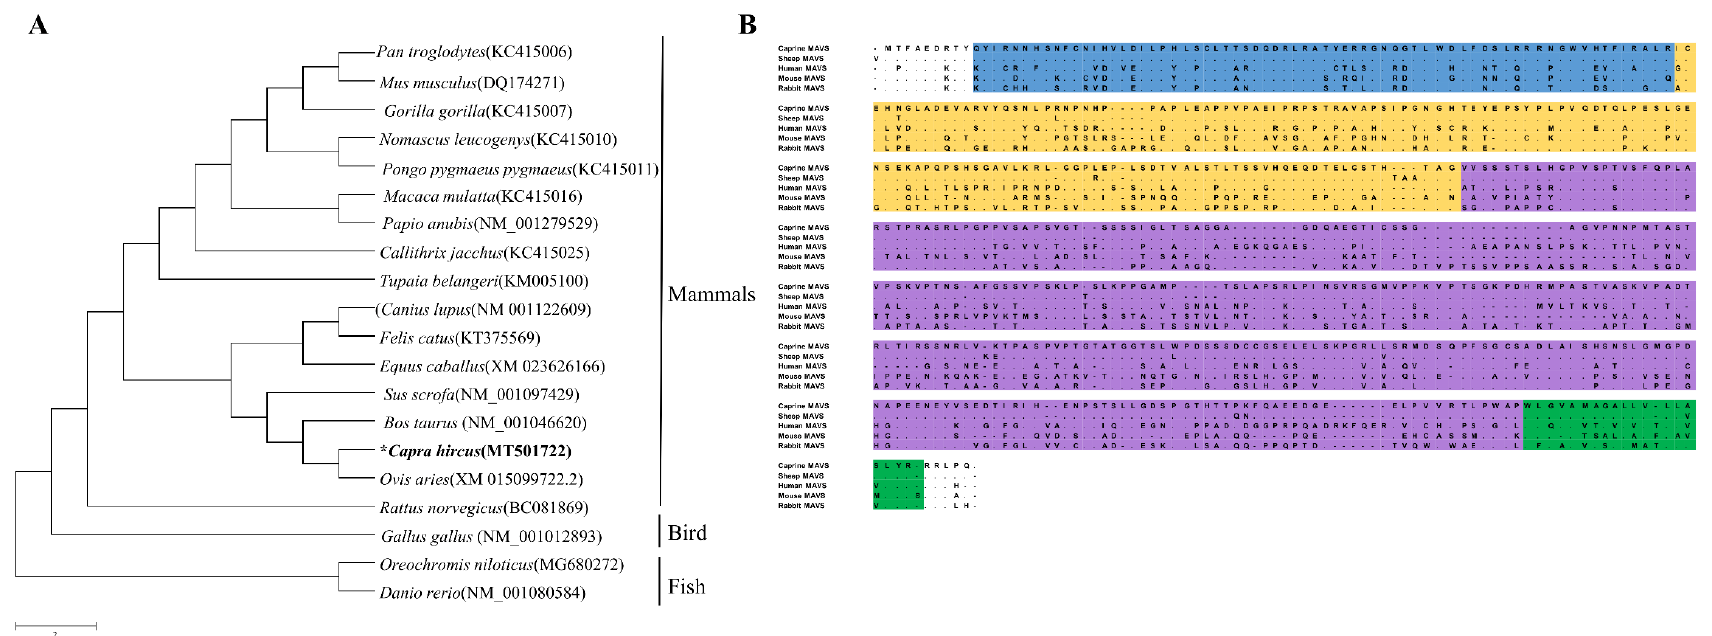
Figure 1. Identification of caprine MAVS. ( A ) Multiple sequences of MAVS from different species were selected to construct the phylogenetic tree. The tree was constructed by using the neighbour-joining method by MEGA5.0 and the scale bar is 2. The amino acid sequences of MAVS used in this program were listed in Table S2. The asterisk indicates caprince MAVS ( B ) Amino acid alignments of caprine, sheep, human, mouse and rabbit MAVS. Sequence alignments were performed and edited with the Lasergene MegAlign program. Structural caspase activation and recruitment domain (CARD), proline-rich region (PRR), non-characterized (NC) and C-terminal transmembrane (TM) domains are indicated in blue, yellow, purple, and green, respectively.